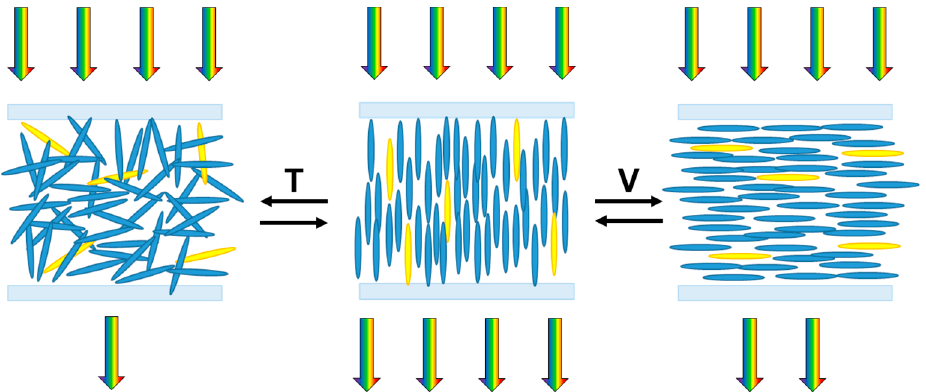
Figure 5. Schematic of liquid crystal and dye alignment in an initial homeotropic state ( middle ) and its changes upon application of an electrical field ( right ) or increased temperature ( left ).